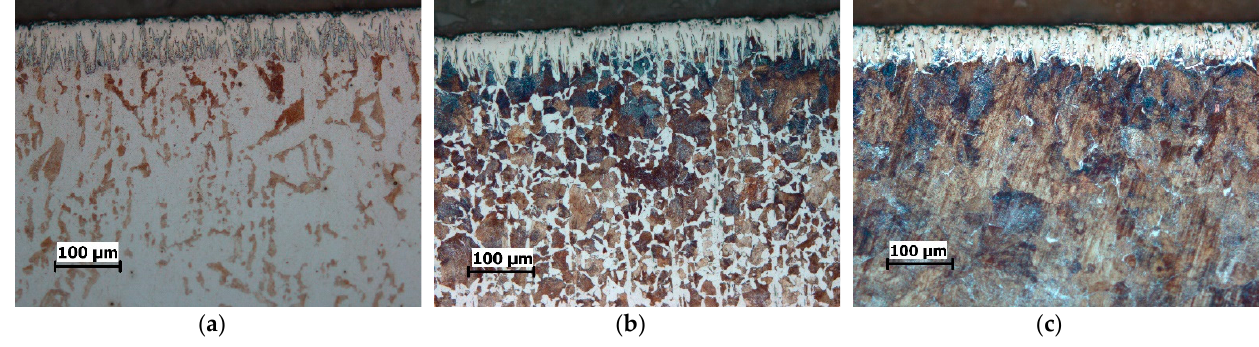
Figure 2. Microstructure of the boride layers obtained by boronizing at 870 °C for 4 h, magnification 200:1: ( a ) C15 steel; ( b ) C45 steel; ( c ) C70W2 steel.